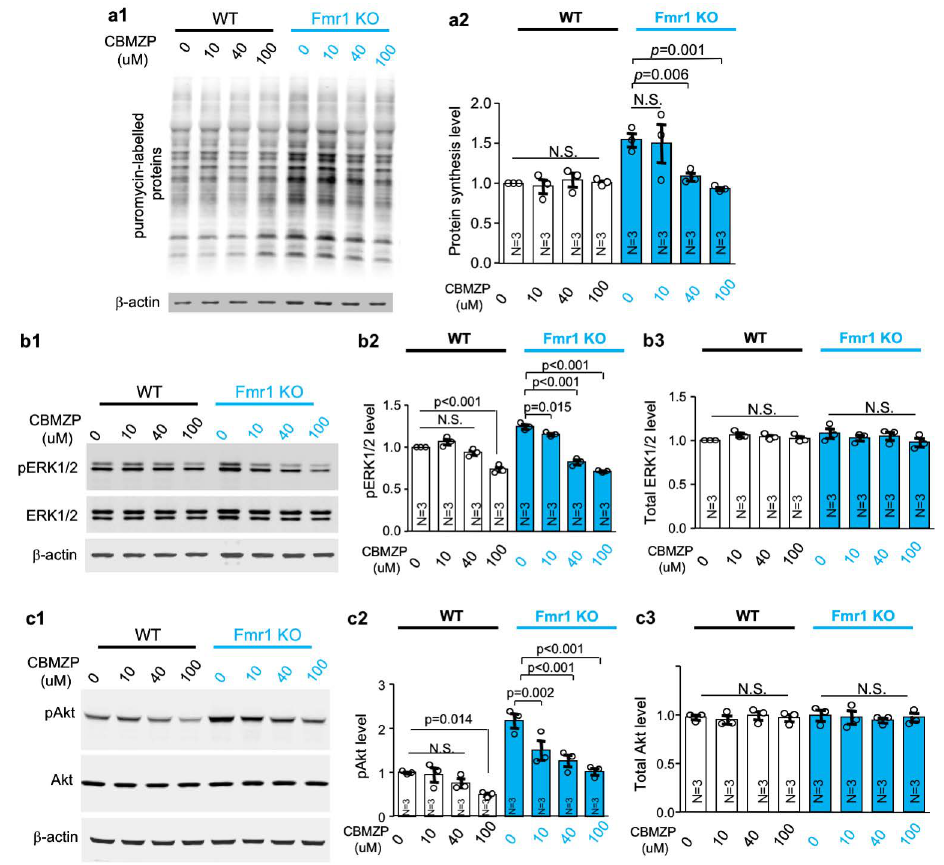
Figure 4. Carbamazepine corrects the aberrantly elevated protein synthesis and neuronal signaling in FXS mouse neurons. DIV (days in vitro) 14 neurons cultured from hippocampus of wild type (WT) and Fmr1 KO mice were treated with various concentrations of carbamazepine (CBMZP, as indicated). Samples were harvested 60 min after treatment. ( a1 , a2 ). Protein synthesis was labelled with puromycin and determined by Western blot with antibody against puromycin. The level of puromycin-labelled protein synthesis was normalized to β -actin. ( b1 – b3 , c1 – c3 ). The level of pERKERK 1 ⁄ 2 and